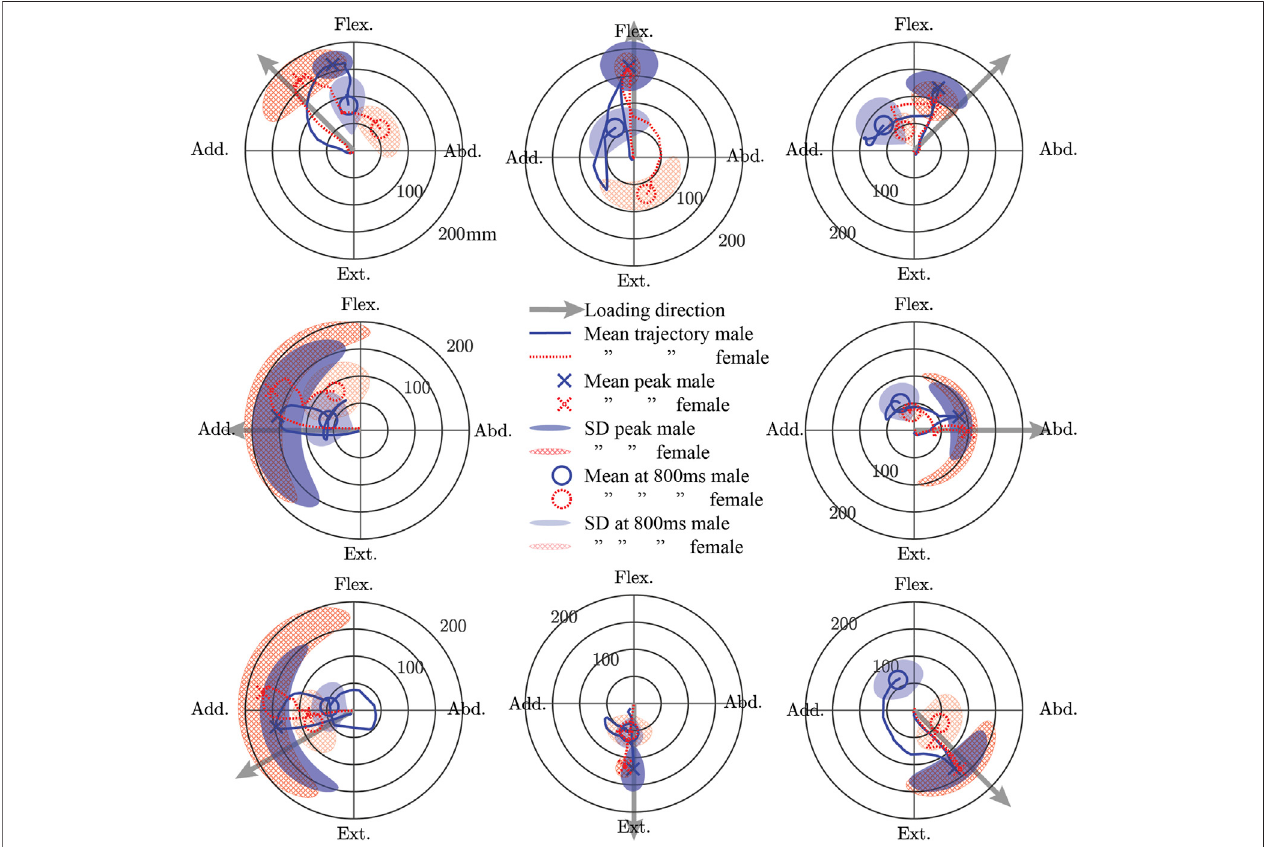
FIGURE5| Themeantrajectoryofapointapproximatelyattheelbowjointcenterinaplaneperpendicular totheinitialorientationofthehumerusshownseparately for male and female subjects in polar coordinates. The peak displacement of the mean trajectory and the displacement of the mean trajectory 0.8 s after weight drop is shown.Furthermore,thestandarddeviation(SD)ofthesubject-wisedisplacementsatthetimeofthepeakmeantrajectoryandat0.8 safterweightdroparealsoshown. Flex., Flexion; Abd., Abduction; Ext., Extension; Add., Adduction.